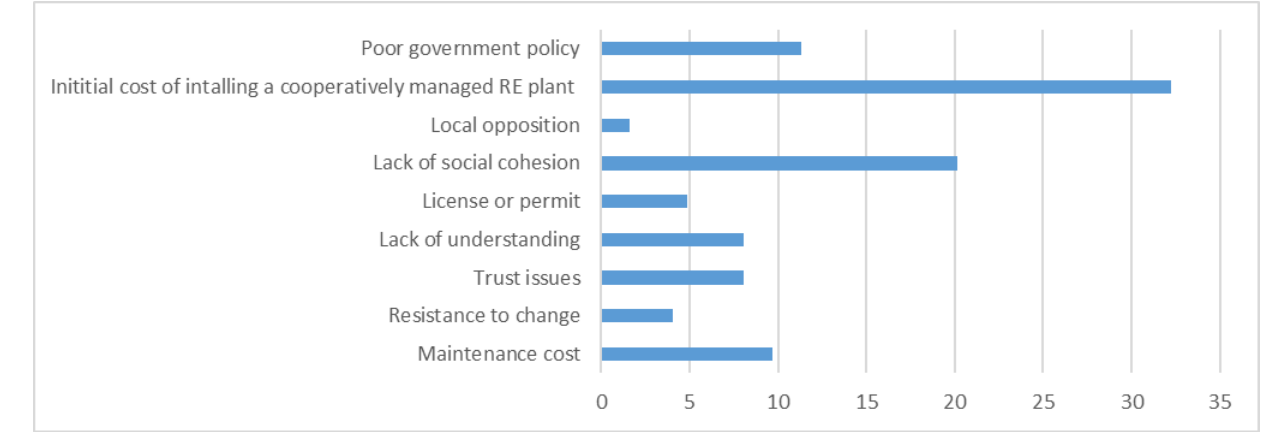
Figure 4. Perceived barriers to the formation of CREIs (in percentages).